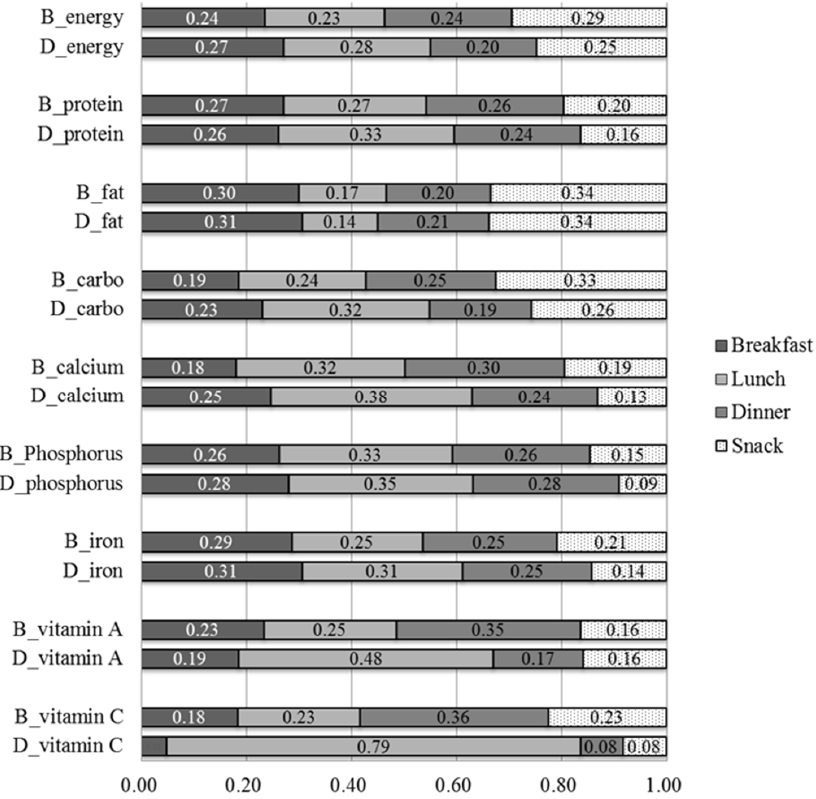
Figure 2. Percentage contributions of breakfast, lunch, dinner, and snacks to the total energy and nutrient intakes before and after the intervention. B_energy or nutrient: intake before the intervention, D_energy or nutrient: intake after the intervention.